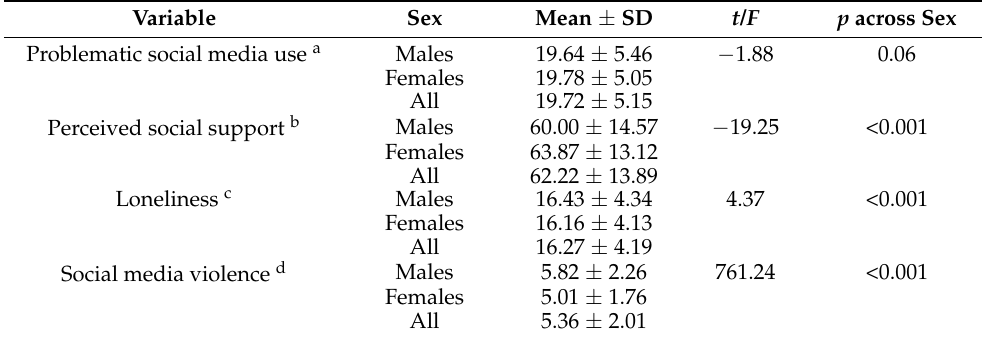
Table 2. Scores for problematic social media use, perceived social support, loneliness, and social media violence for college students in Shaanxi, China: Overall and by